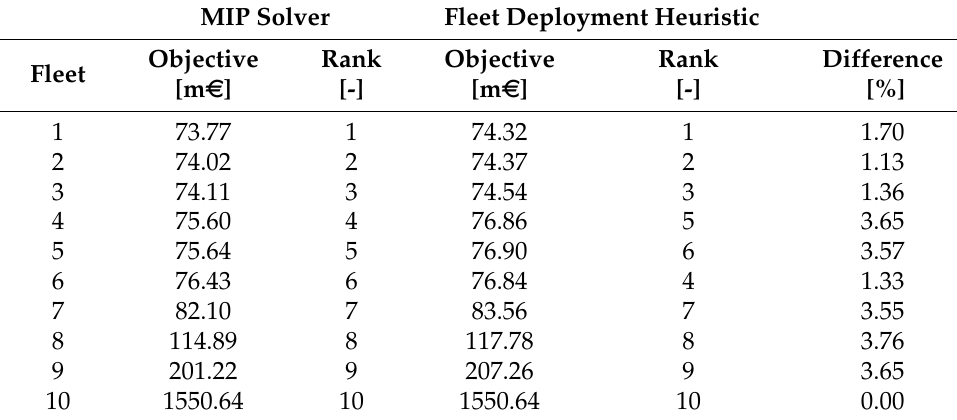
Table 1. Ranking of fleets according to objective function